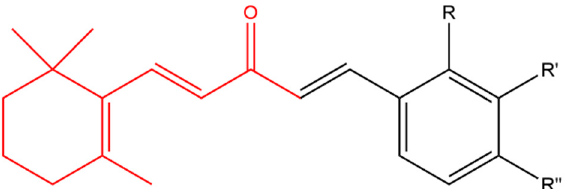
Figure 8. (Compound a ). R = H, R’ = H, R” = NO 2 ; [(1 E ,4 E